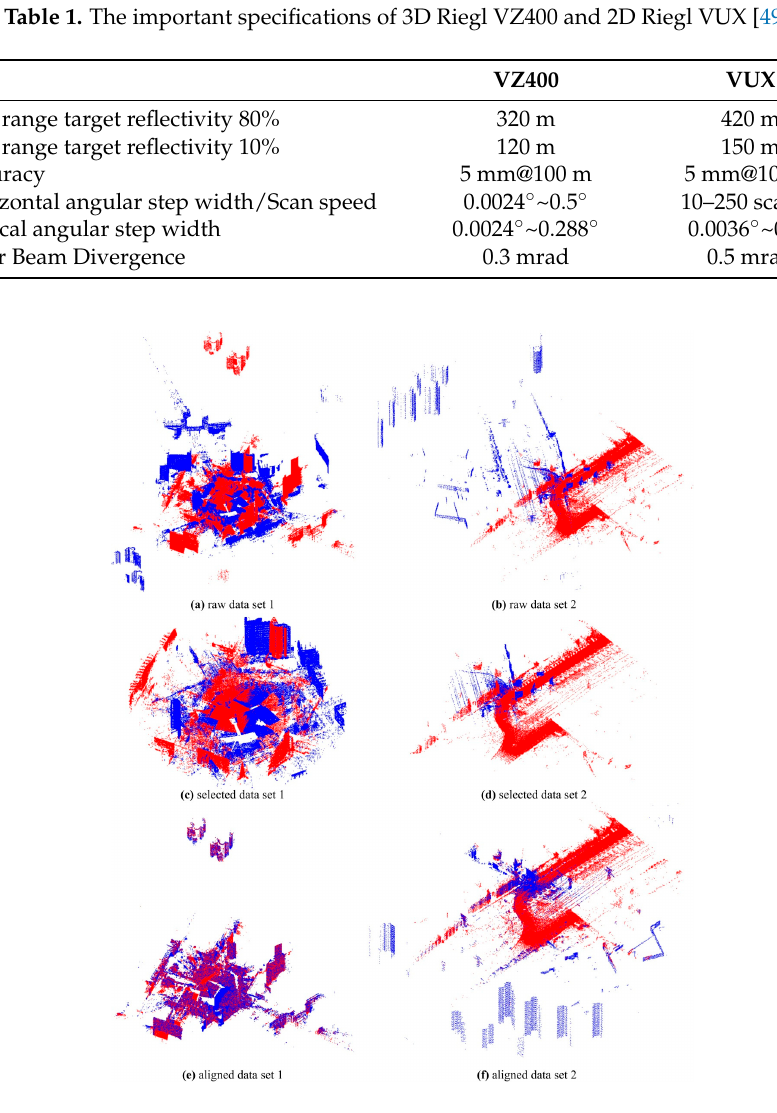
Figure 5. The test datasets. The red data are target point clouds and the blue data are source point clouds. ( a ) The raw point clouds of data set 1; ( b ) the raw point clouds of data set 2; ( c ) the point clouds of data set 1 after selection of matching points; ( d ) the point clouds of data set 2 after selection of matching points; ( e ) the registered point clouds of data set 1; ( f ) the registered point clouds of data set 2.